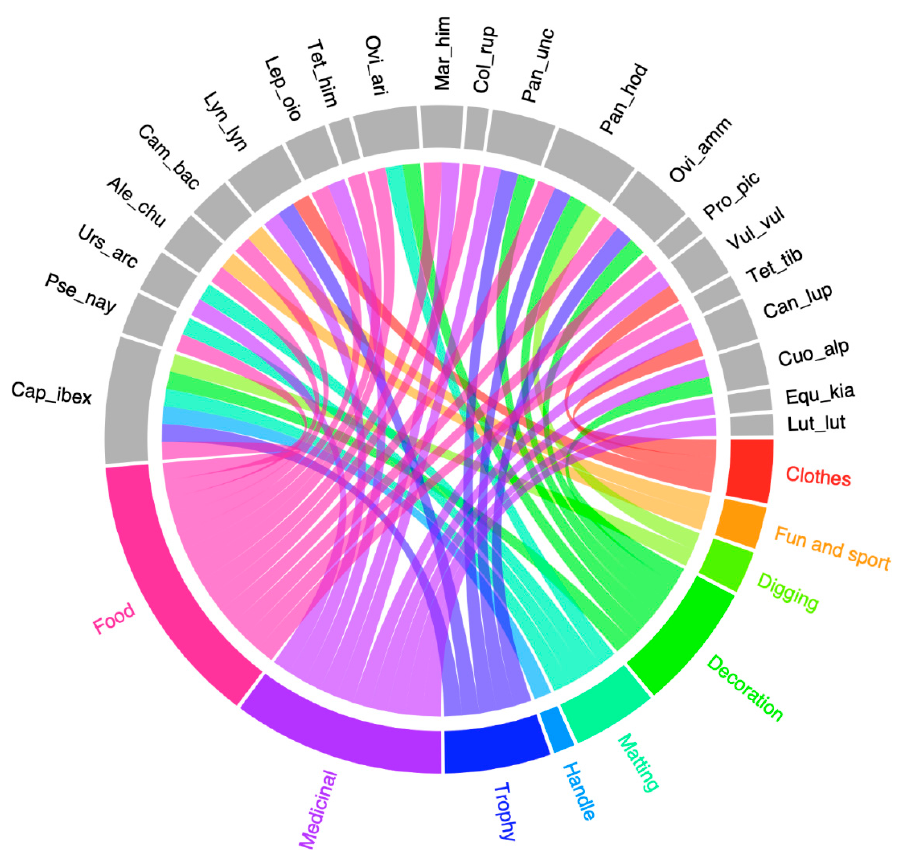
Figure 7. Preference analysis of animal species distribution according to animal usage in Ladakh trans-Himalayan region, India. Full animal names are depicted in Table 1.